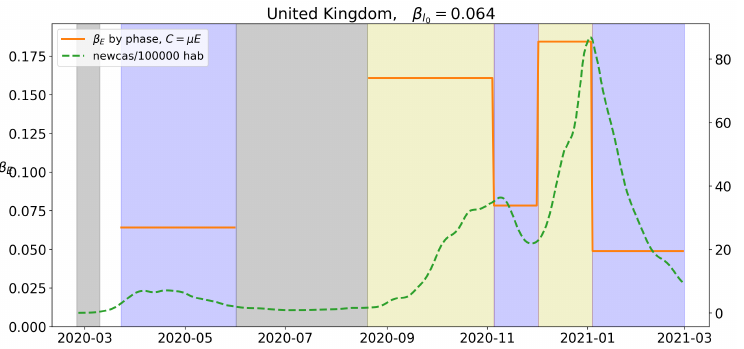
Figure 12. Value of β E for the different levels of lockdown. Blue will correspond to Stage 1, yellow to Stage 3 and white to Stage 4. A green dotted line corresponds to the value of new cases per 100,000 hab.